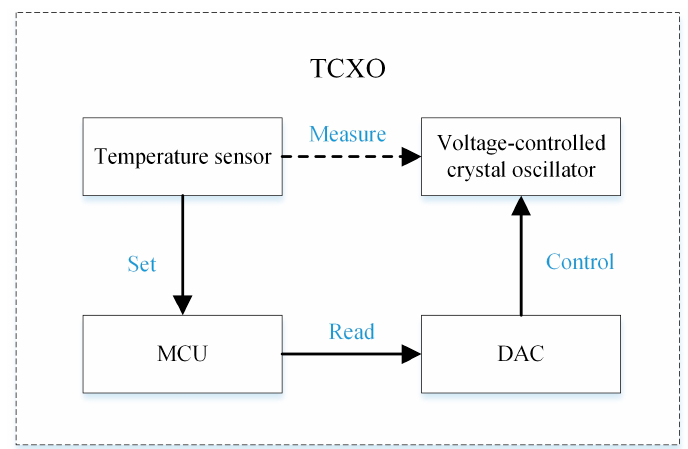
Figure 3. Temperature-compensated X’tal (crystal) oscillator (TCXO) structure block diagram. Note: Micro Controller Unit (MCU); Digital to Analog Converter (DAC).